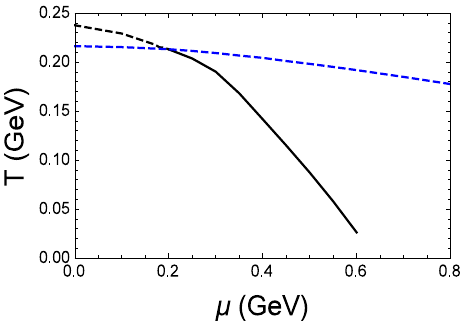
Figure 9. The ( T; (cid:22) ) phase diagram for chiral and decon(cid:12)nement phase transitions. The blue dashed line is for decon(cid:12)nement phase transition and the black line is for the chiral phase transition,